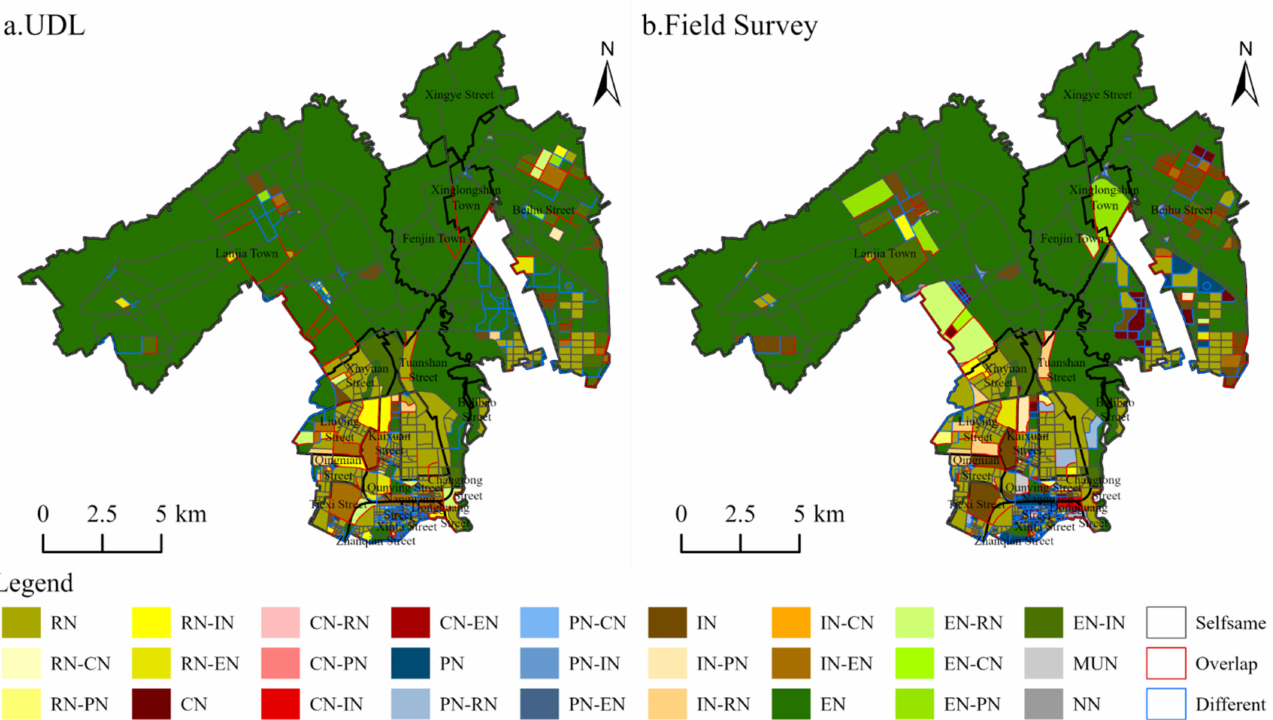
Figure 9. Comparison of ( a ) UDL and ( b ) field survey